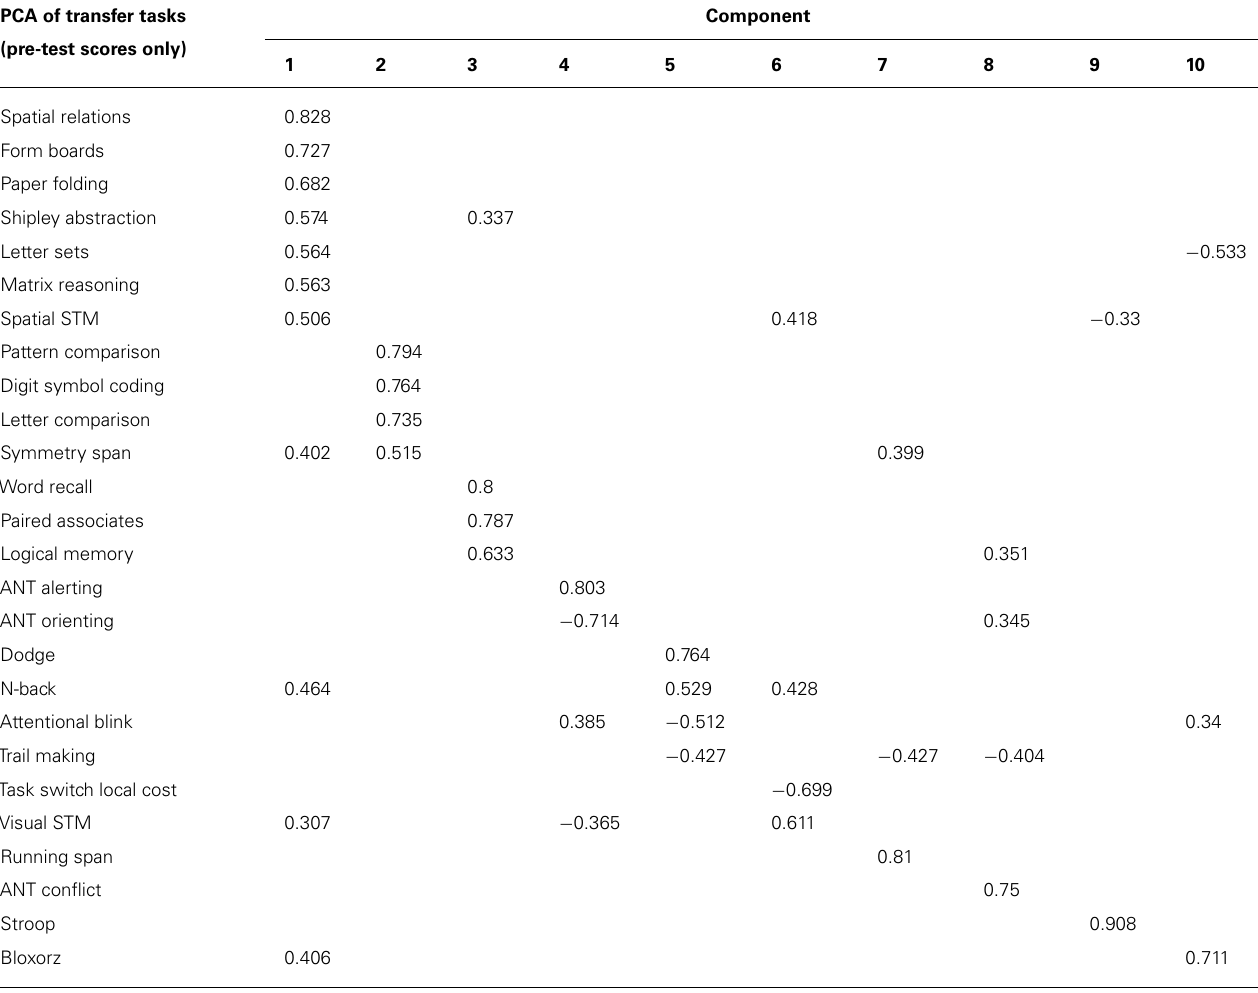
Table 4 |Transfer tasks: principal components analysis using baseline